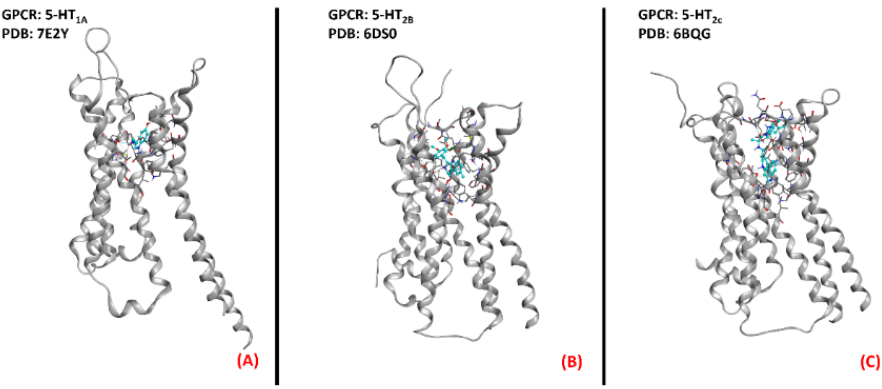
Figure 12. The chemical structures of the serotonin receptor modulators are treated in this review. The selective 5-HT 2B antagonist SB204741 ( A ), the 5-HT 2B agonist BW723C86 ( B ). ( C ) Structure of the 5-HT 2B/C mixed inverse agonistSB206553; ( D ) chemical structure of Cyproheptadine, a non-selective mixed serotonin receptor antagonist (which is an inverse agonist of 5-HT 2B ). ( E ) Structureof the 5-HT 1A receptor agonist Xaliproden.